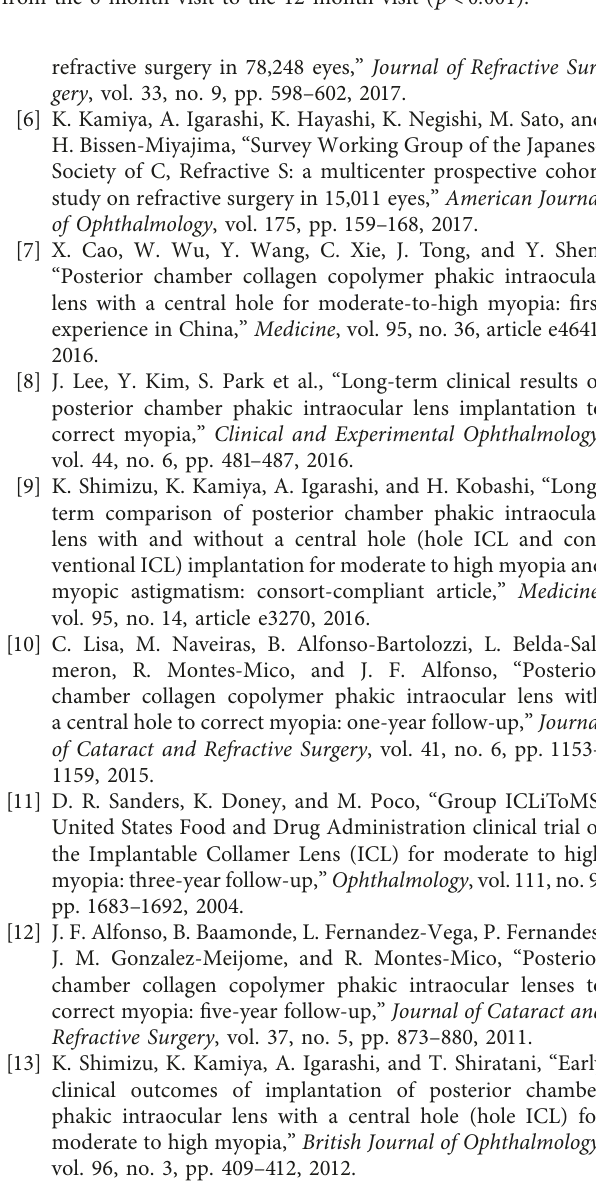
Figure 8: Mean vault of the phakic IOL ( n � 58, repeated measures ANOVA, all visits, p < 0 . 001). Statistically significant difference was observed from the 1-month visit to the 6-month visit ( p � 0 . 04) and from the 6-month visit to the 12-month visit ( p < 0 .